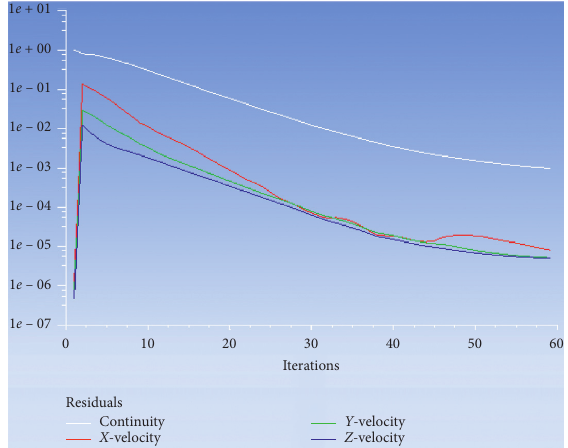
Figure 6: Residual